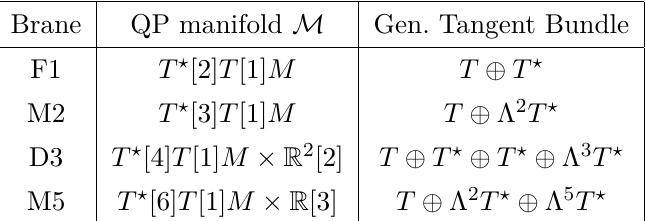
Table 1 . p -branes and their associated generalised geometries. All bundles have base M . (The source Q-manifold is N = T [1]Σ where the p -dimensional manifold Σ is a spatial section of the